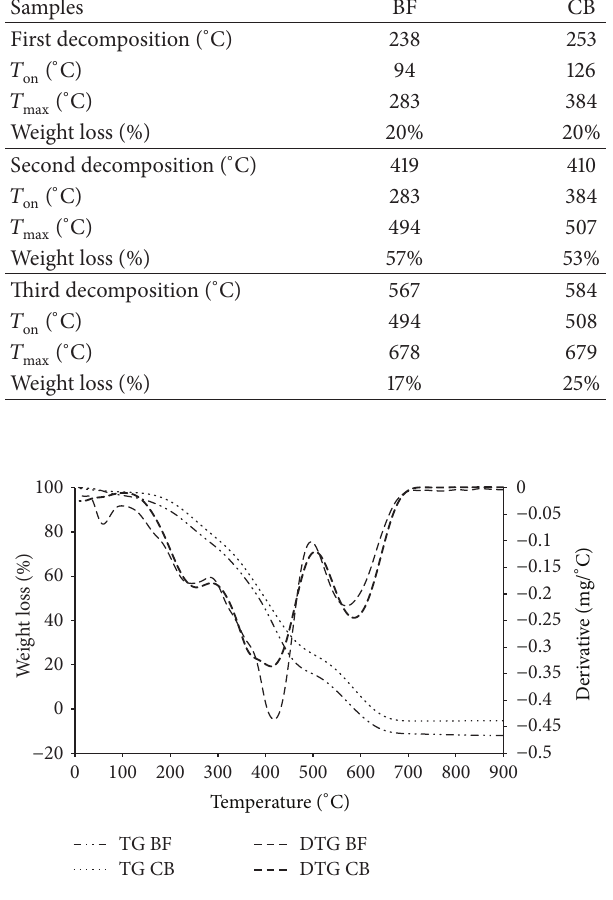
Figure 1: Thermogram (TG) and derivative weight loss (DTG) of BF and CB samples.